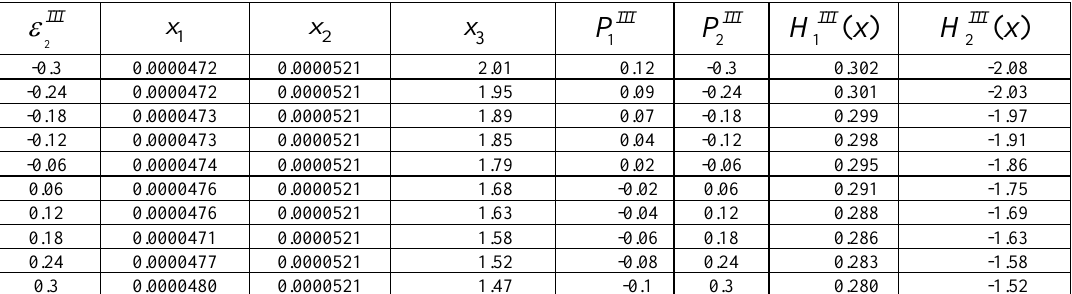
Table 6. Efficient solutions for the third